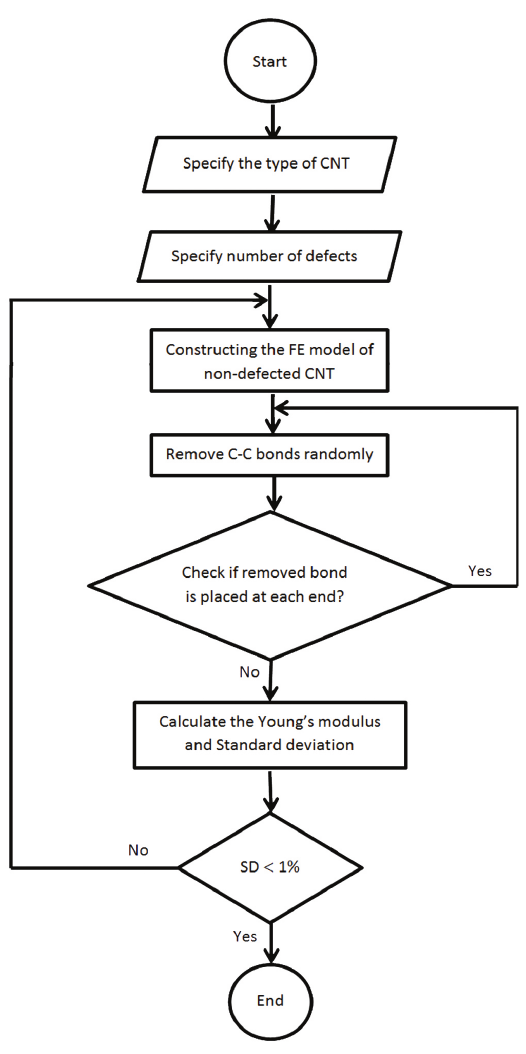
Figure 6. Flowchart of modeling and analysis process of defected Table 2. Results comparison for CNT with vacancy defect.